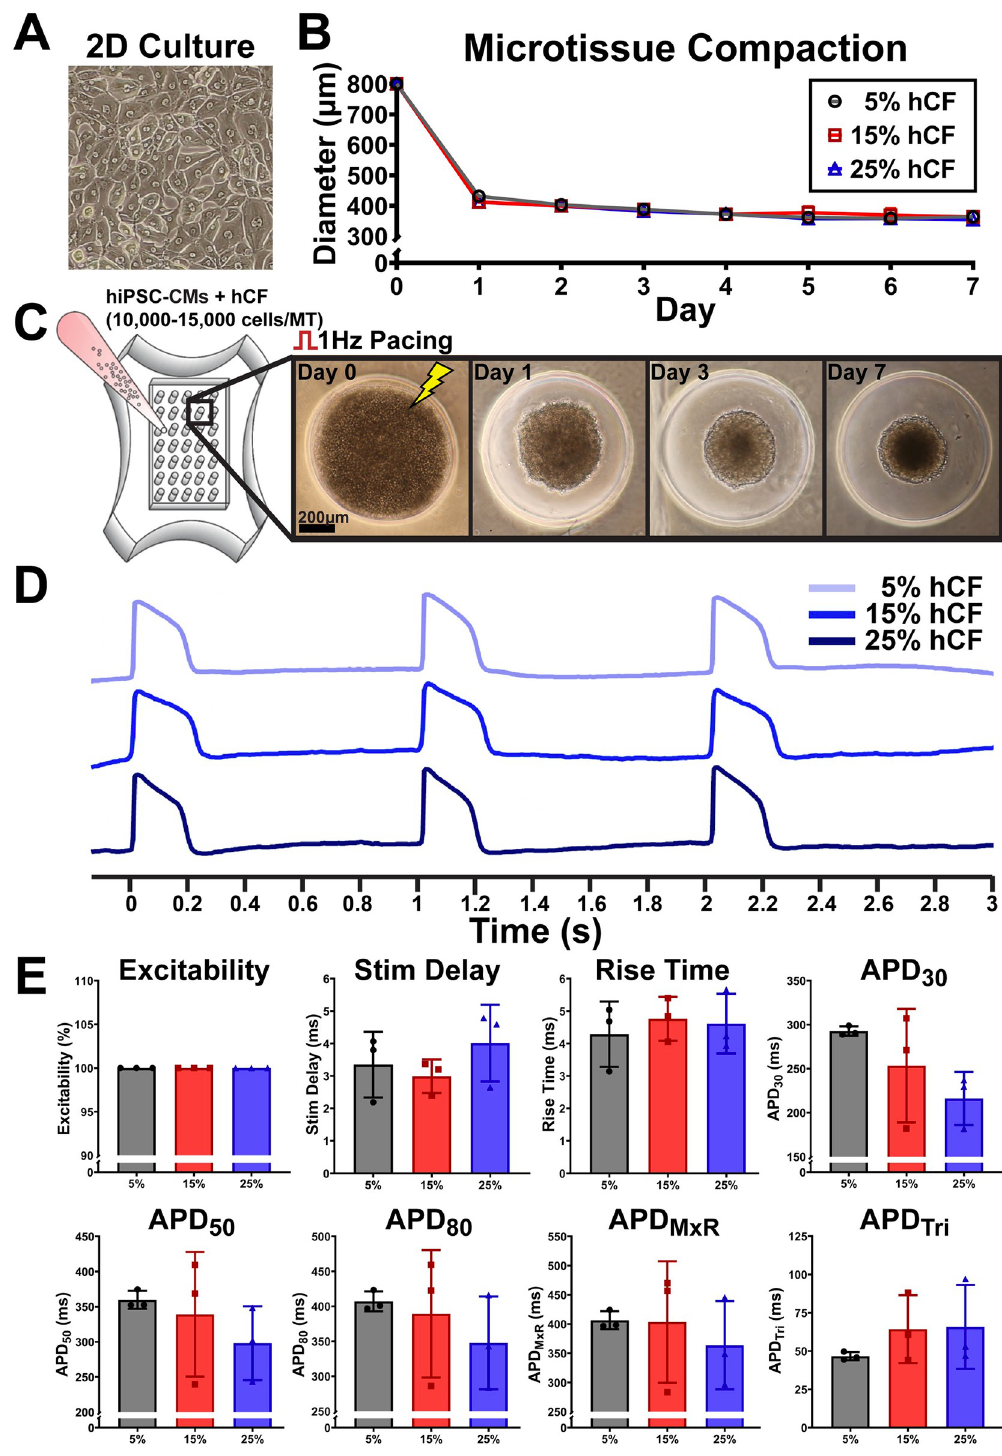
Fig 3. Effects of human cardiac fibroblast (hCF) percentage on microtissue compaction and characterization of AP. (A) Phase-contrast image of 2D culture of purified hiPSC-CMs for microtissue generation. (B) Microtissue compaction assessed by reduction in spheroidal microtissue diameter over 7 days of culture. (C) Sample images illustrating microtissue compaction over indicated time. (D) Sample action potential traces with indicated hCF content. (E) AP characteristics of microtissues with indicated hCF content recorded after 6–8 days in culture. Each dot represents averaged AP metrics from each mold (n = 3 molds, 32–35 microtissues per mold). https://doi.org/10.1371/journal.pone.0280406.g003 PLOS ONE | https://doi.org/10.1371/journal.pone.0280406 February 6,